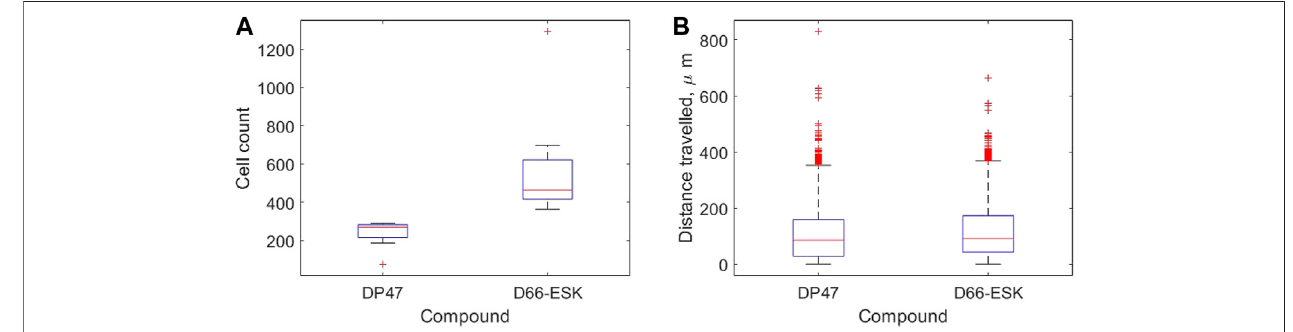
FIGURE 4 | Summaries of PBMC in fi ltration data at 48 h grouped by compound. (A) The total number of in fi ltrating cells. (B) The distribution of distances travelled per in fi ltrating cell away from the interface with the bottom channel in μ